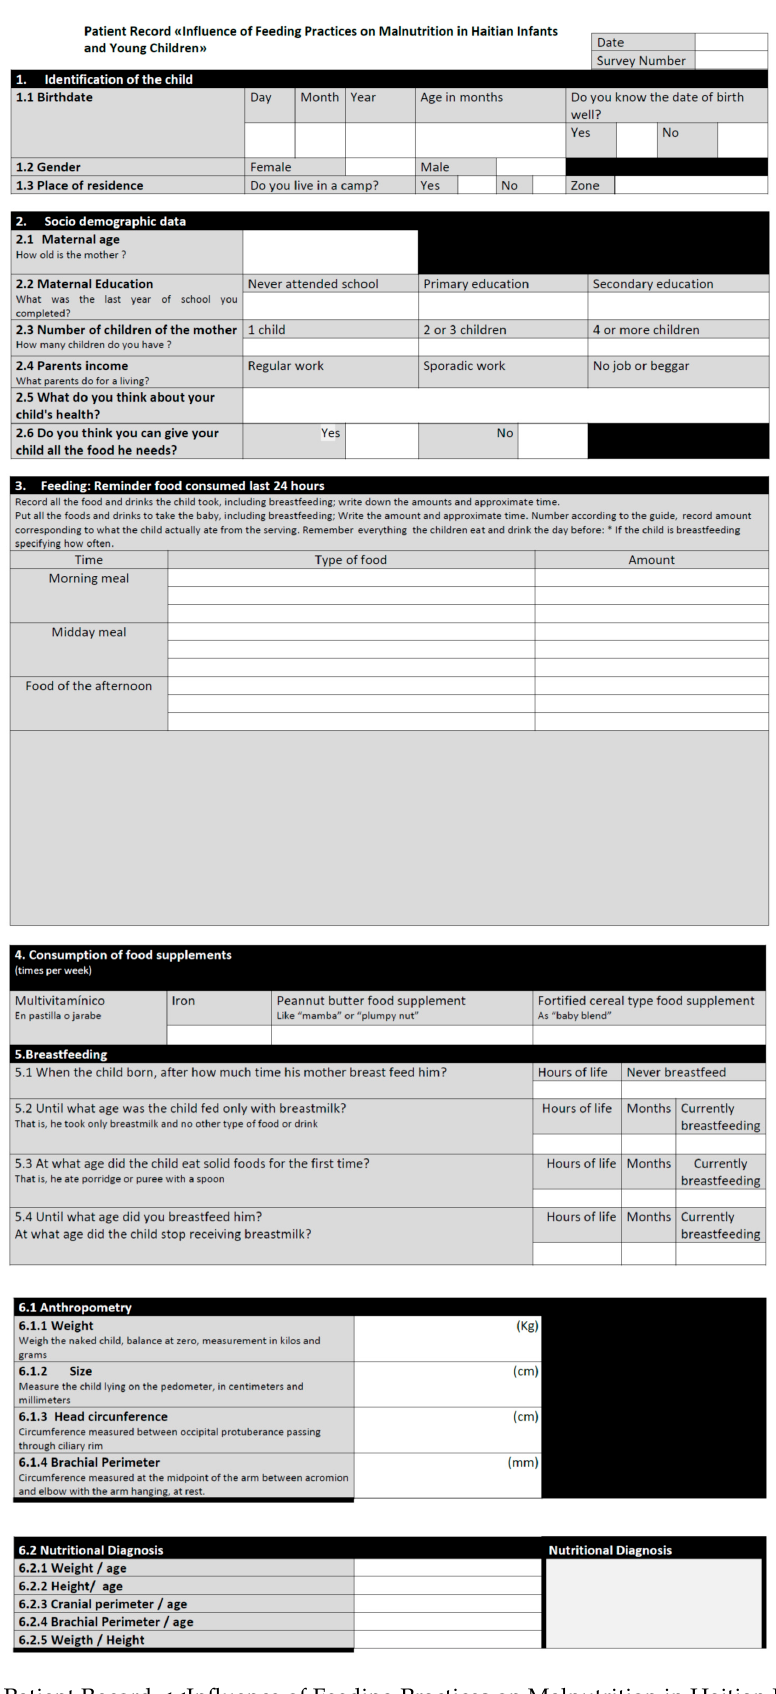
Figure A1. Patient Record <<Influence of Feeding Practices on Malnutrition in Haitian Infants and Young Children>>.